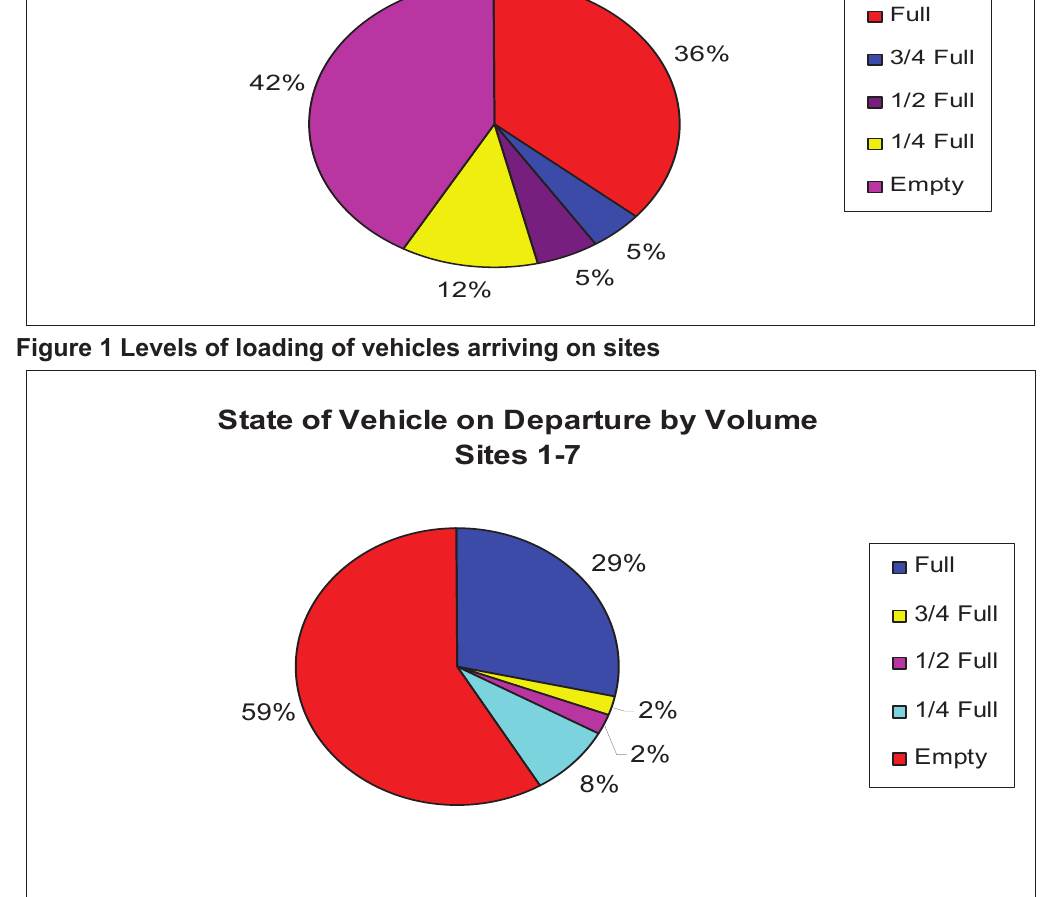
Figure 2 Levels of loading of vehicles departing